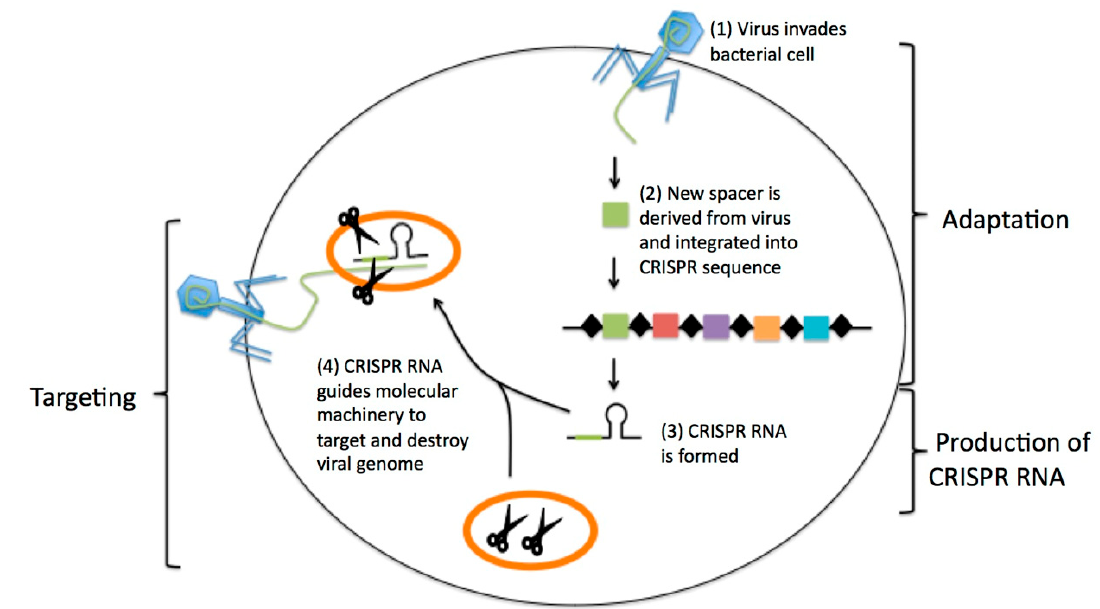
Figure 4. The principle of the clustered regularly interspaced short palindromic repeats (CRISPR)- based technique for the detection of SARS-CoV-2. CRISPR/Cas12 and CRISPR/Cas13 are used to detect the viral RNA of SARS-CoV-2. The Cas13 complex binds to the target sequences. This binding activates the general nuclease enzyme activity of Cas13 to cleave the target sequence. The RNA is then detected by a fluorescence signal. The activity of Cas12 is similar to the activity of Cas13. One difference between the two is the position of the nuclease enzyme. Adapted by permission. Copyright